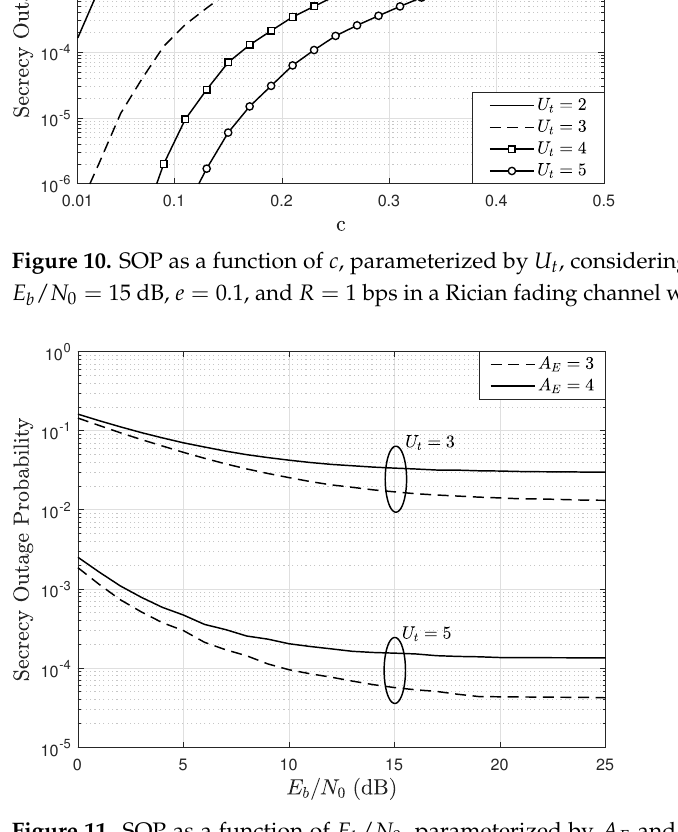
Figure 11. SOP as a function of E b / N 0 , parameterized by A E and U t , considering M = 4, A = 3, U = 3, e = 0.1, c = 0.05, and R = 1 bps in a Rician fading channel with K =